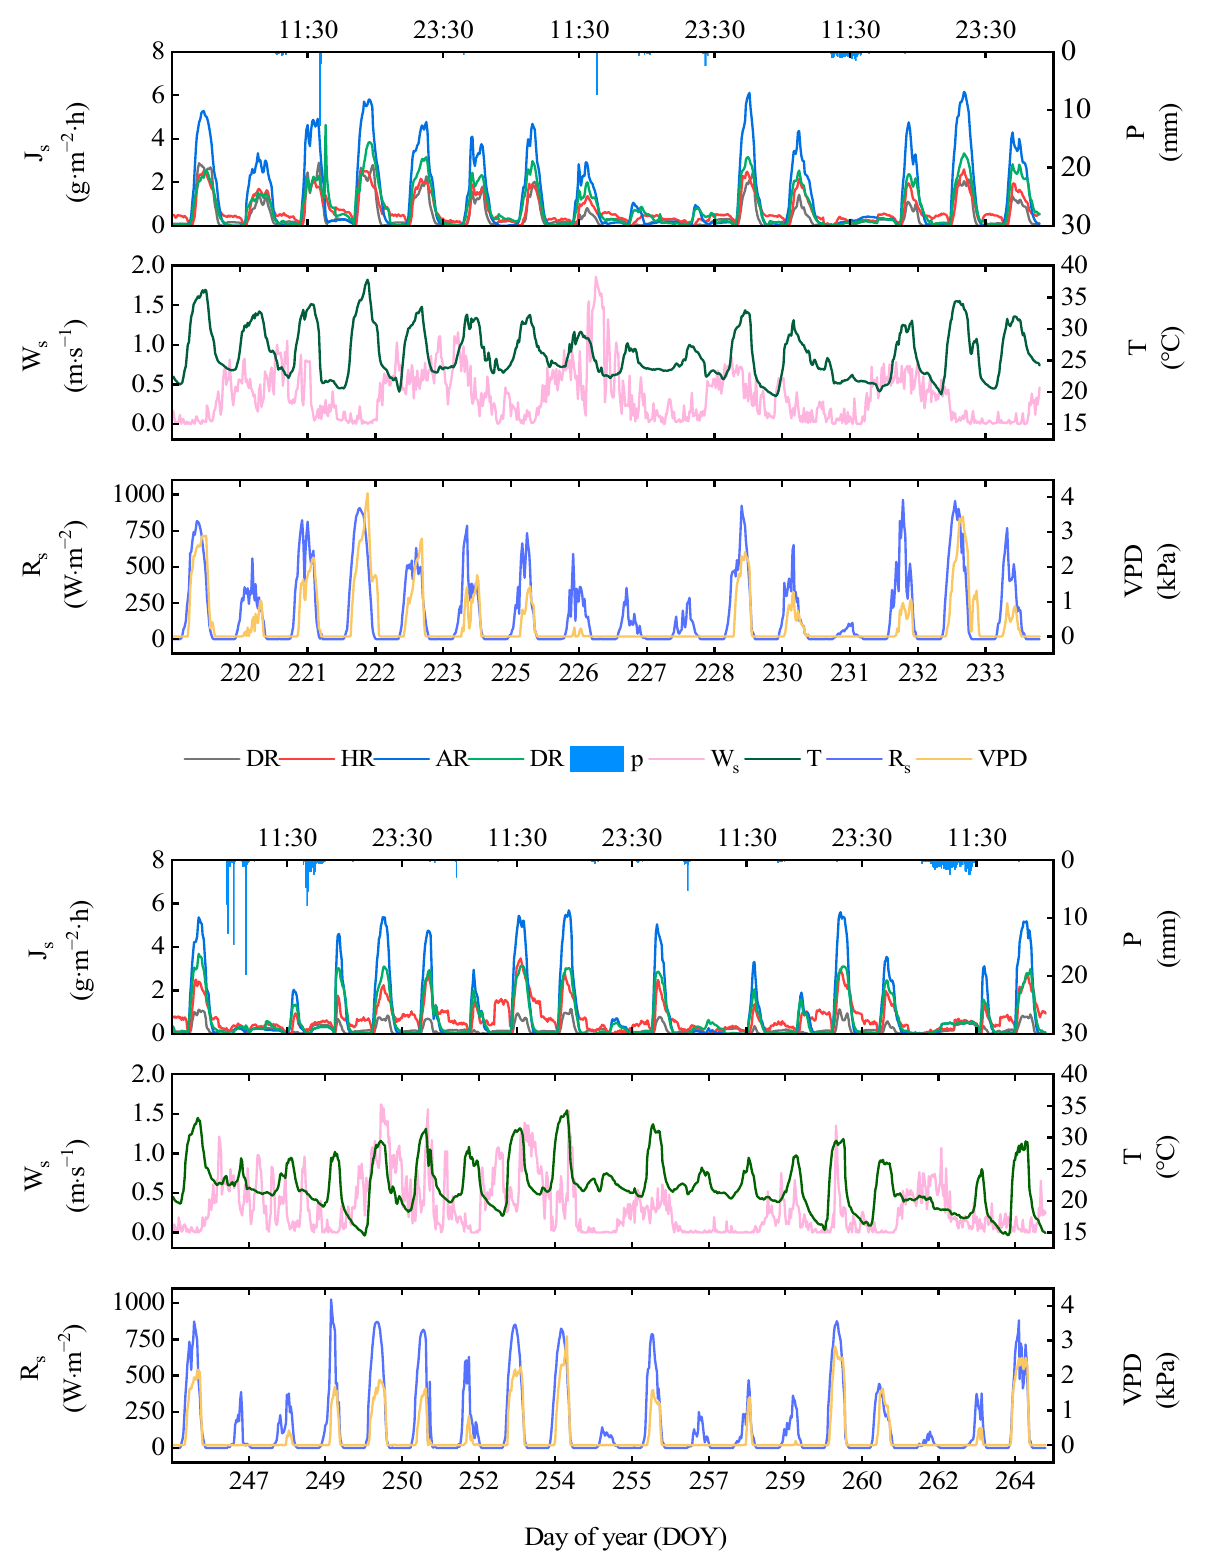
Figure 8. Diurnal variation of NR treatment sap flow (NR), HR treatment sap flow (HR), AR treatment sap flow (AR), DR treatment sap flow (DR), precipitation (P), air temperature (T), solar radiation (R S ), wind speed (W S ) and vapor pressure deficit